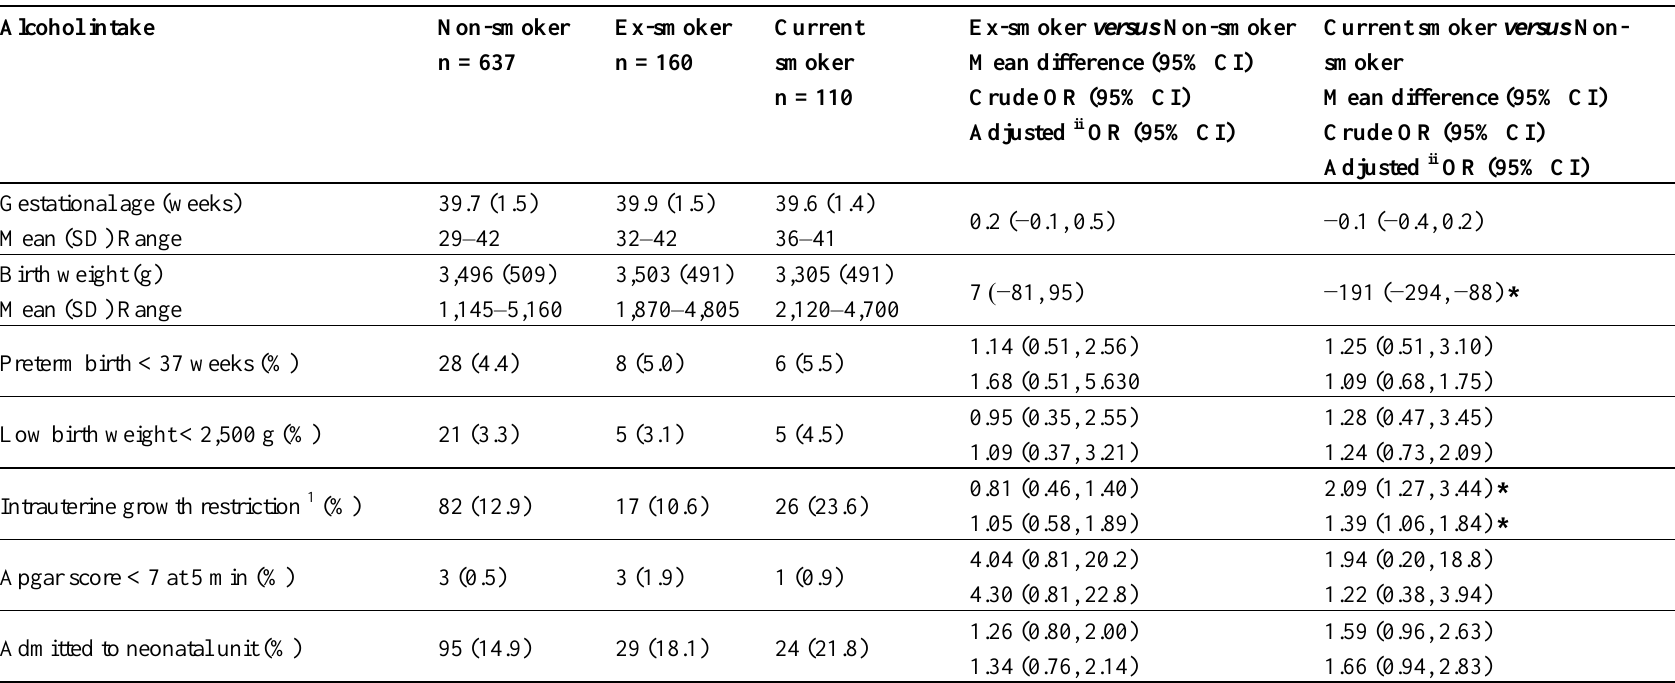
Table 4. Perinatal outcomes according to reported smoking behaviour at booking visit and third trimester of